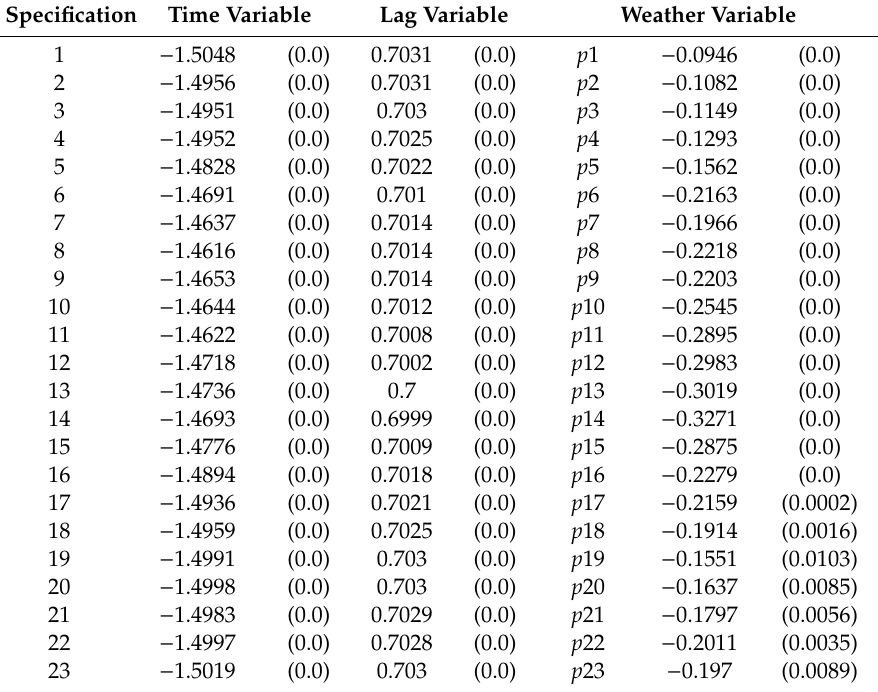
Table 2. Estimation results for time, lag performance, and